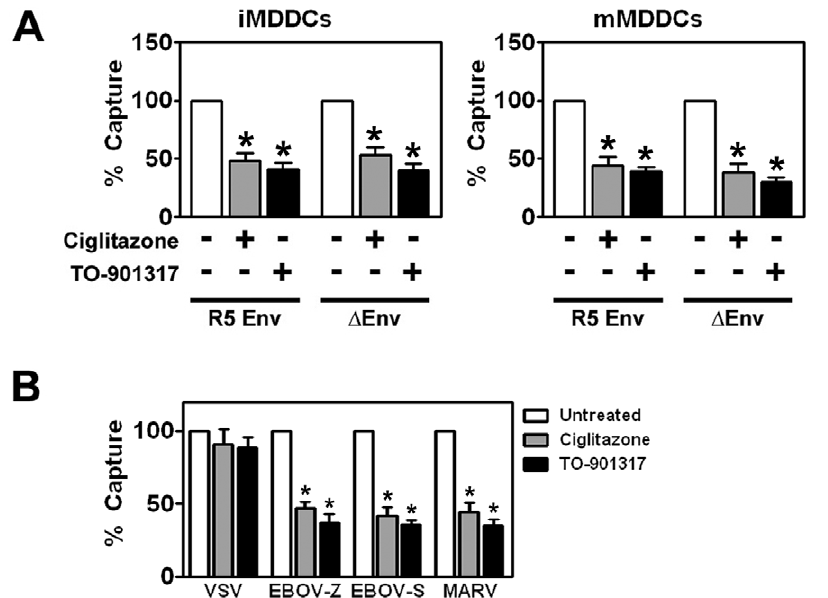
Figure 8. PPAR c and LXR ligand treatment prevents envelope glycoprotein-independent capture of virus by MDDCs. (A) Immature (left panel) and mature (right panel) MDDCs were treated with 100 m M ciglitazone or 1 m M TO-901317 and incubated with a single round replication- competent HIV-1 reporter virus encoding luciferase that was either pseudotyped with R5-tropic envelope glycoproteins (R5) or that lacked envelope glycoproteins ( D Env). Virus capture was measured by p24 gag ELISA. (n=3) (B) Immature MDDCs were treated with100 m M ciglitazone or 1 m M TO- 901317 and incubated with a single round replication-competent HIV-1 reporter virus encoding luciferase that was packaged with envelope glycoproteins from VSV (VSV-G), Ebola virus Zaire (EboV-Z), Ebola virus Sudan (EboV-S), or Marburg virus (MarV). Virus capture was measured by p24 gag ELISA. Mean capture values for untreated iMDDCs: 1.13 ng VSV-G-pseudotyped HIV-1; 251.83 pg EBOV-Z-pseudotyped HIV-1; 324.10 pg EBOV-S-pseudotyped HIV-1; and 415.07 pg MARV-pseudotyped HIV-1. (n=3) * p , 0.001 compared to untreated controls. (VSV), Ebola virus (EboV), and Marburg virus (MarV). As shown